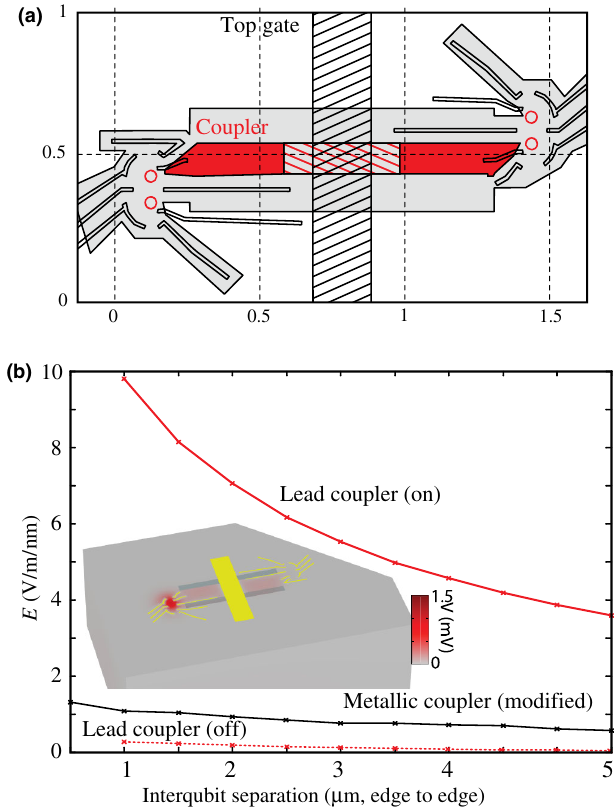
FIG. 7. Simulations of single-spin qubits show appreciable coupling strengths, even over distances of several microns. While the metallic coupler design of Fig. 6 modified to place the quantum dots at the edges of the couplers is effective [black crosses in (b)], an all-in-2DEG design where one of the leads of the qubit acts as a coupler [red region in (a)] provides dramati- cally enhanced coupling [solid red lines in (b)]. The coupler is deactivated by a metallic top gate [black hatched region in (a)], modeled by removing the hatched section of the coupler. The deactivation reduces interqubit coupling by over an order of magnitude [dashed red curve in